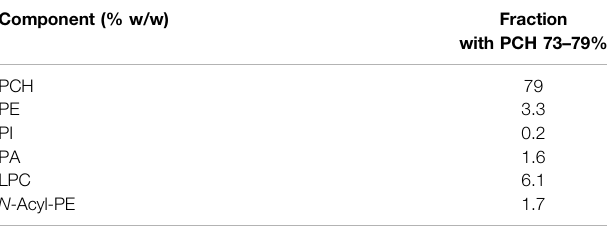
TABLE 1 | Phospholipid composition of the soybean lecithin extract and chromatography fraction with PC content of 73 – 79% (Van Hoogevest and Wendel,